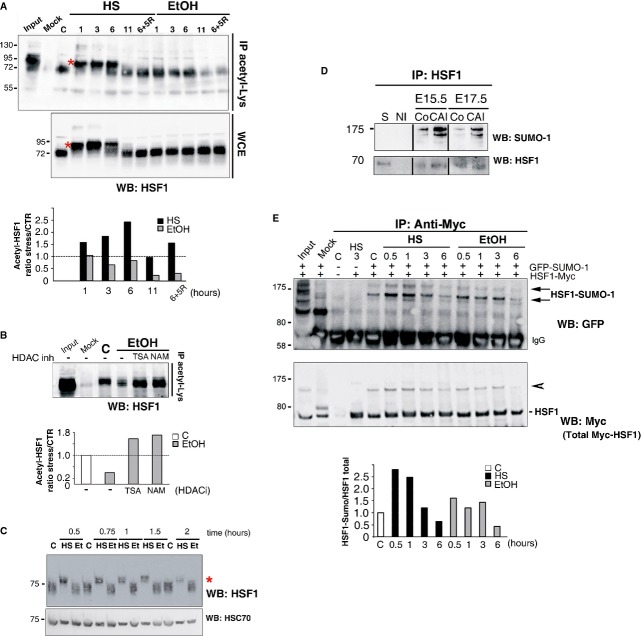
Persistent alcohol-induced HSF1 activation correlates with alcohol-specific post-translational modificationsA   Acetylation of HSF1 is observed upon HS, but not EtOH exposure. (Upper panel) Representative immunoprecipitation of the acetylated form of endogeneous HSF1 detected with an anti-acetyl-lysine antibody in N2A cells (IP acetyl-Lys). HS (42°C) or EtOH exposure (0.5%) was carried out for 1–11 h, or for 6 h followed by 5 h of recovery (6+5R). (Middle panel) Immunoblot of HSF1 in whole cell extracts (WCE). C, untreated cells; mock: immunoprecipitation in the absence of specific antibodies. Input: HS, 3 h. The shift in HSF1 migration in HS samples is due to its typical heat-induced hyperphosphorylation [red asterisk; see also (C)]. (Lower panel) Corresponding quantification of the relative levels of acetylated HSF1 after HS or EtOH exposure compared to control conditions.B   HDAC inhibition by TSA or NAM restores HSF1 acetylation upon EtOH stress. (Upper panel) Immunoprecipitation as in (A). (Lower panel) Corresponding quantification of the relative levels of acetylated HSF1 before and after EtOH exposure, with or without HDAC inhibitors (TSA and NAM).C   Lack of HSF1 hyperphosphorylation in response to EtOH. Immunoblot of HSF1 in a 7% SDS–PAGE. iMEFs were analyzed at different times following HS at 41°C or 2% EtOH (Et) exposure. Hsc70: loading control. Red asterisk, shifted hyperphosphorylated HSF1 form.D   HSF1 is sumoylated upon chronic fetal alcohol exposure in cortices. Immunoprecipitation of HSF1 from control fetal cortices at E15.5 or E17.5 (Co) or after CAI and immunoblotting with anti-SUMO-1 (upper panel) or anti-HSF1 antibodies (lower panel). S: supernatant (E15.5). NI: non-immune serum.E   Limited HSF1 sumoylation in response to EtOH. (Upper panel) Immunoprecipitation of Myc-tagged human HSF1 (HSF1) and immunoblot analysis of HSF1 sumoylation. N2A cells, cotransfected with Myc-tagged human HSF1 and GFP-fused SUMO-1 expression vectors, were exposed to a 42°C HS or to 0.75% EtOH. Arrows point to sumoylated HSF1 forms. (Middle panel) Total Myc-tagged HSF1; the arrowhead points to HSF1-Myc forms that likely correspond to the sumoylated forms, according to their molecular weight. Input and mock (immunoprecipitation using anti-HA antibody) are shown for control (C) N2A cells. (Lower panel) Corresponding quantification of the ratio between the sumoylated form of HSF1 and total HSF1 amounts.See also Supplementary Figs S5, S6, and S7.Source data is available for this figure.